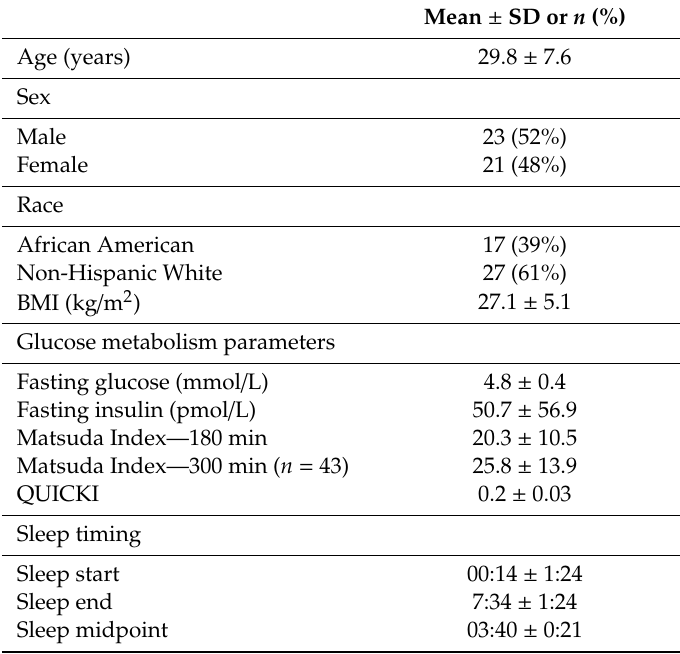
Table 1. Clinical characteristics, sleep parameters and glucose metabolism parameters of study participants ( n = 44).